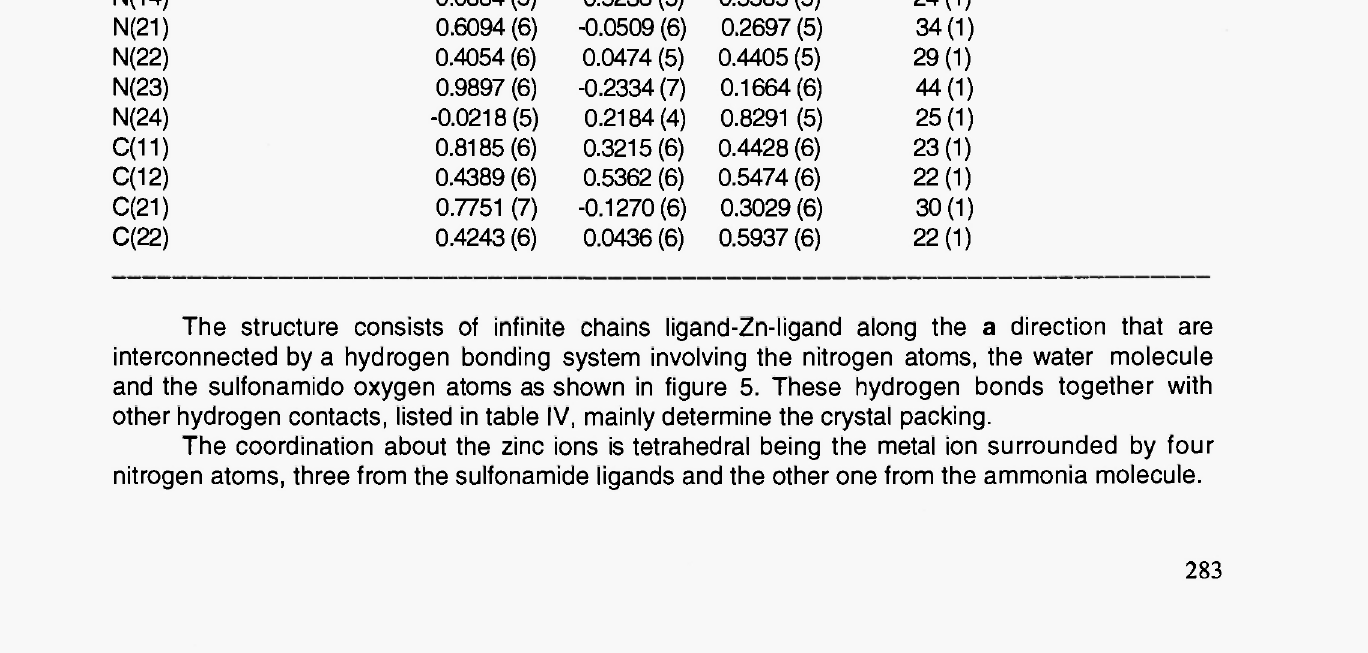
Table II. Atomic Coordinates and Thermal Parameters for Non Η-Atoms Thermal Parameters as